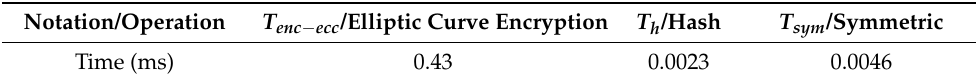
Table 5. Operations’ Timing